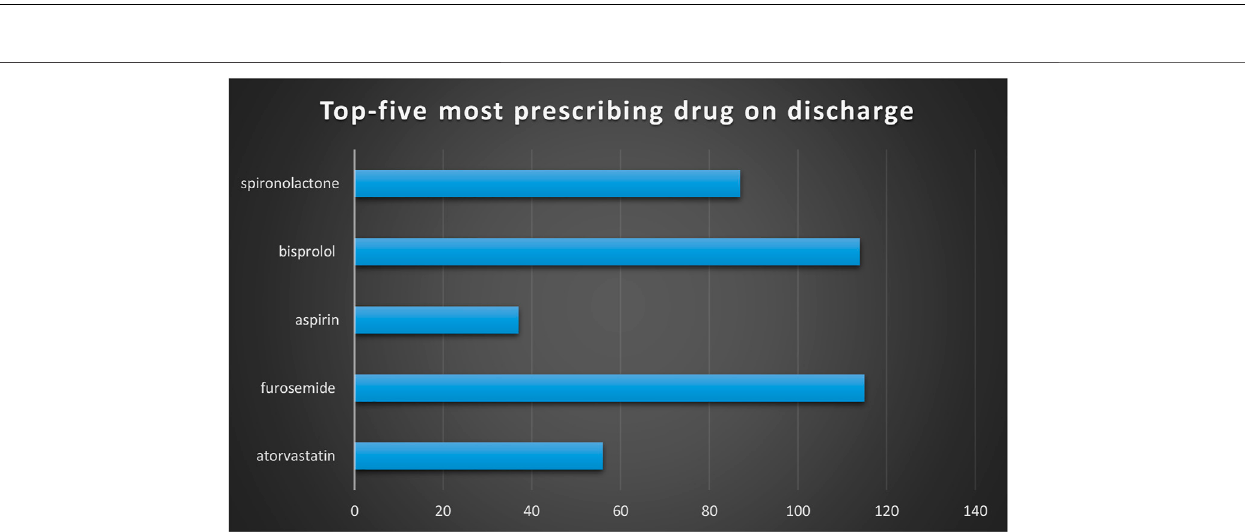
FIGURE 2 | bar graph for top- fi ve most prescribing drugs on discharge.Furosemide/bisprolol/spironolactone/aspirin/atorvastatin.